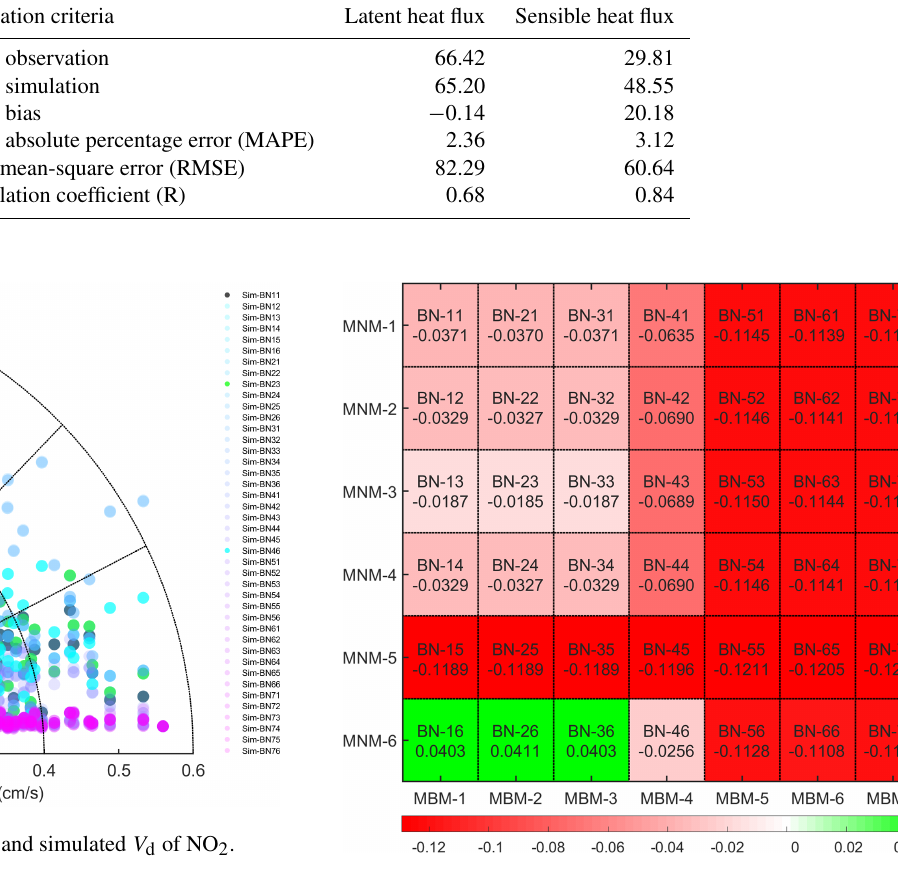
Figure 3. Mean bias of observed and simulated V d